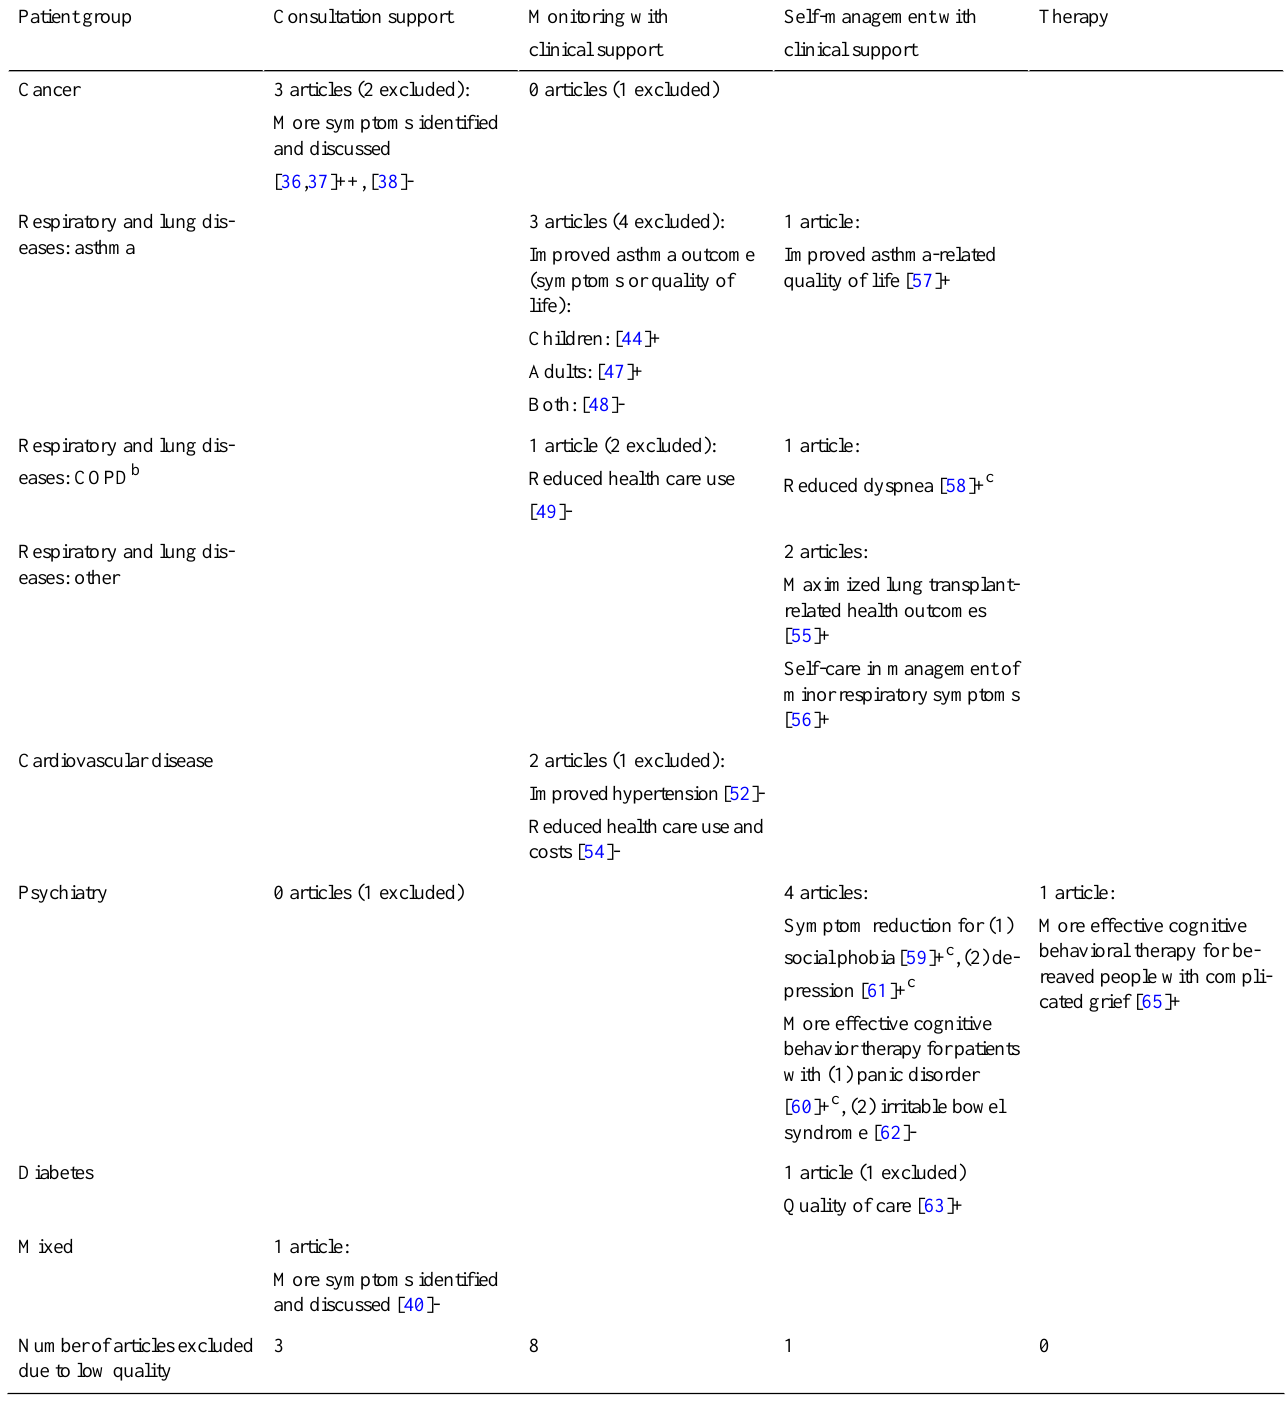
Table 6. Main research focus and overview of confirmed (+) and not confirmed (–) hypothesis for articles included in effect review of randomized controlled trials of electronic symptom reporting, by health service innovation category and patient group a . TherapySelf-management with supportMonitoring with supportConsultation supportPatient clinical clinical